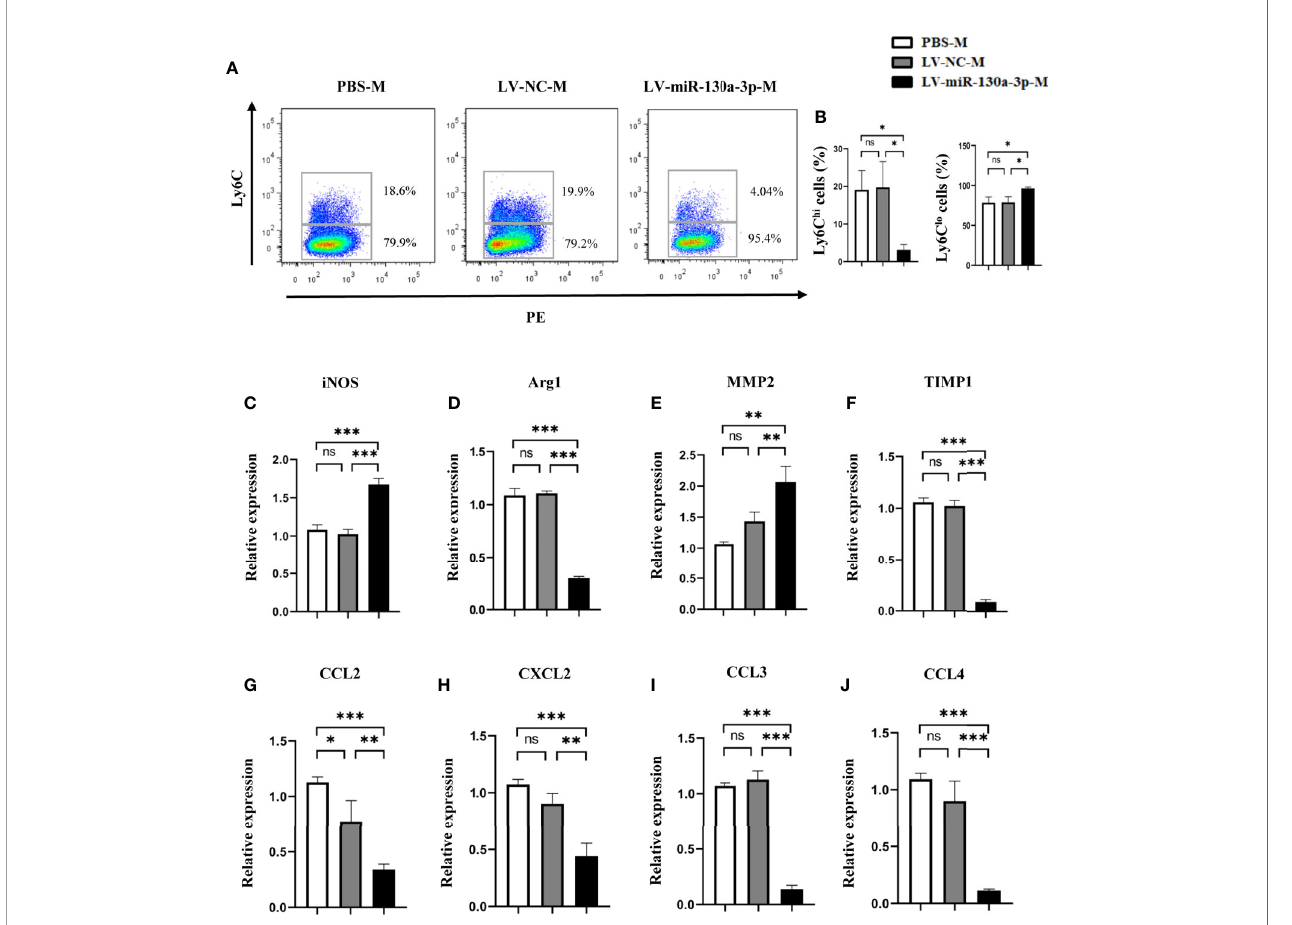
FIGURE 4 | LV-miR130a-3p drove liver macrophages to Ly6C lo skewing. Macrophages were isolated from the liver in S. japonicum -infected mice from different groups by density gradient centrifugation and then were puri fi ed according to the surface marker of F4/80 and CD11b by FCM. The expressions of Ly6C on the LV- miR130a-3p-M surface were respectively detected by FCM (A, B) . The liver macrophage RNA was extracted to analyze in fl ammatory chemokines (C-F) . The liver macrophage RNA was extracted to analyze chemokines, CCL2, CXCL2, CCL3, and CCL4 (G – J) . Data represent mean±SD from multigroup experiments. * p < 0.05, ** p <0.01 and *** p <0.001 (n=4 each group). ns, no signi fi